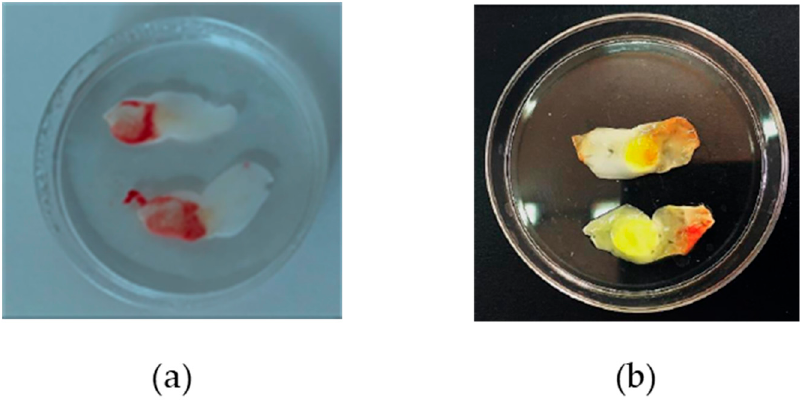
Figure 11. L-PRF membranes before ( a ) and after ( b ) permeation tests.